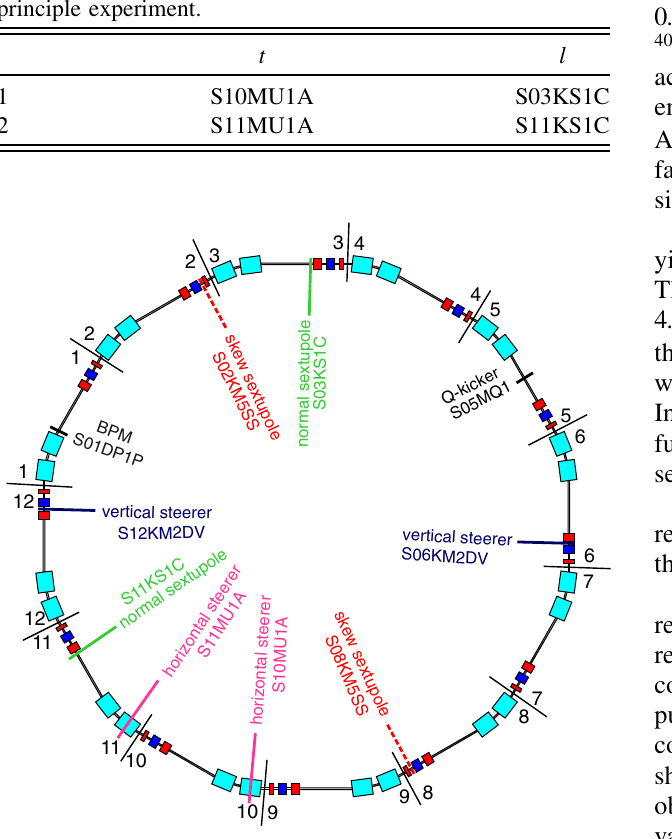
FIG. 5. (Color) SIS18 layout and magnet and steerers used for the proof of principle experiment.